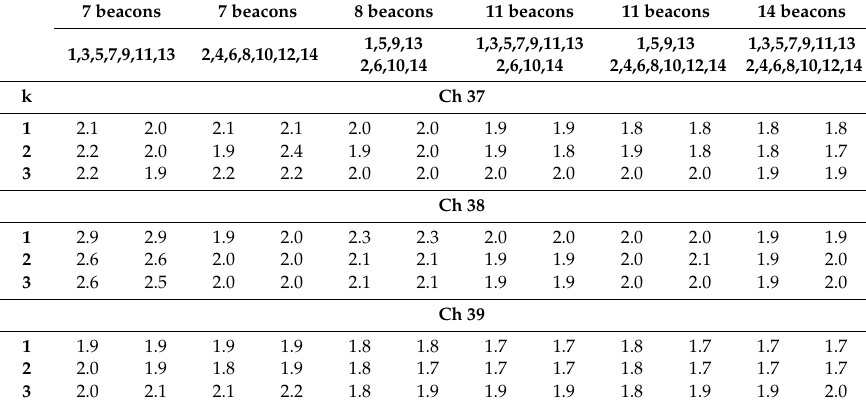
Table 27. Accuracies (in m) for Tests #10, Tx code 7. For each number of beacons, the first and second data columns refer to the iBeacon and Eddystone protocol respectively. The first row shows the total number of beacons and the second shows the labels of the beacons used (see Figure 8b). The three advertising channels are referred to as Ch 37, etc., and the number of neighbors in the WKNN algorithm, as k . 7 beacons